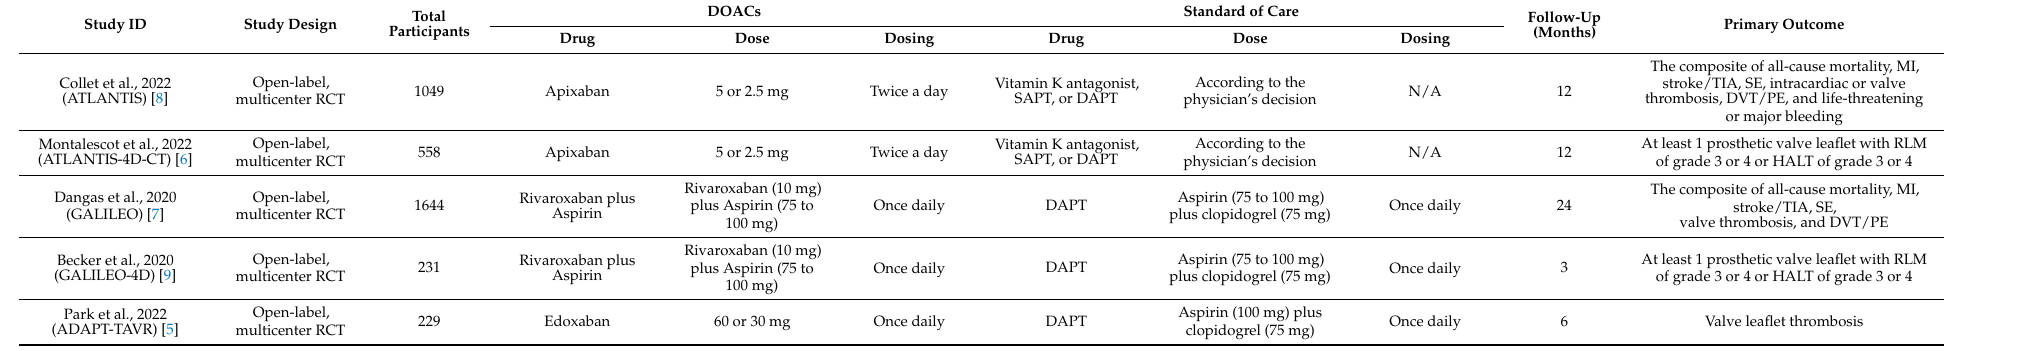
Table 2. Characteristics of the included studies.